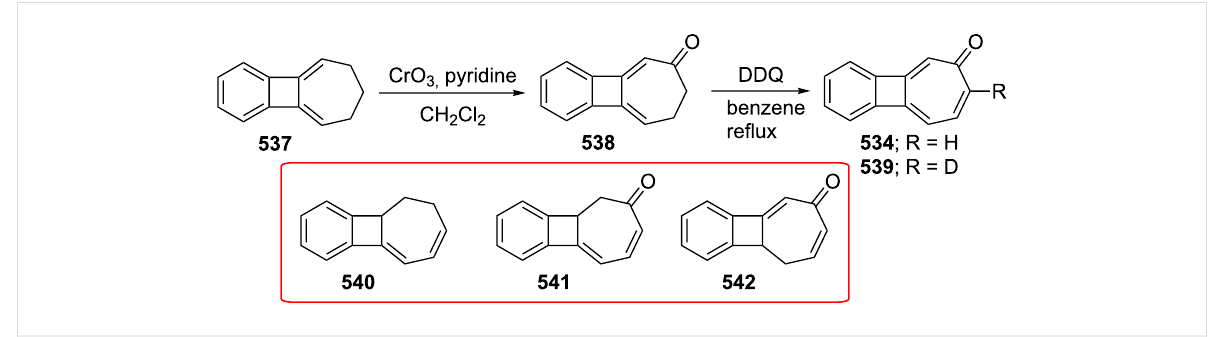
Scheme 96: Synthesis of benzocyclobutatropones 534 and 539 .